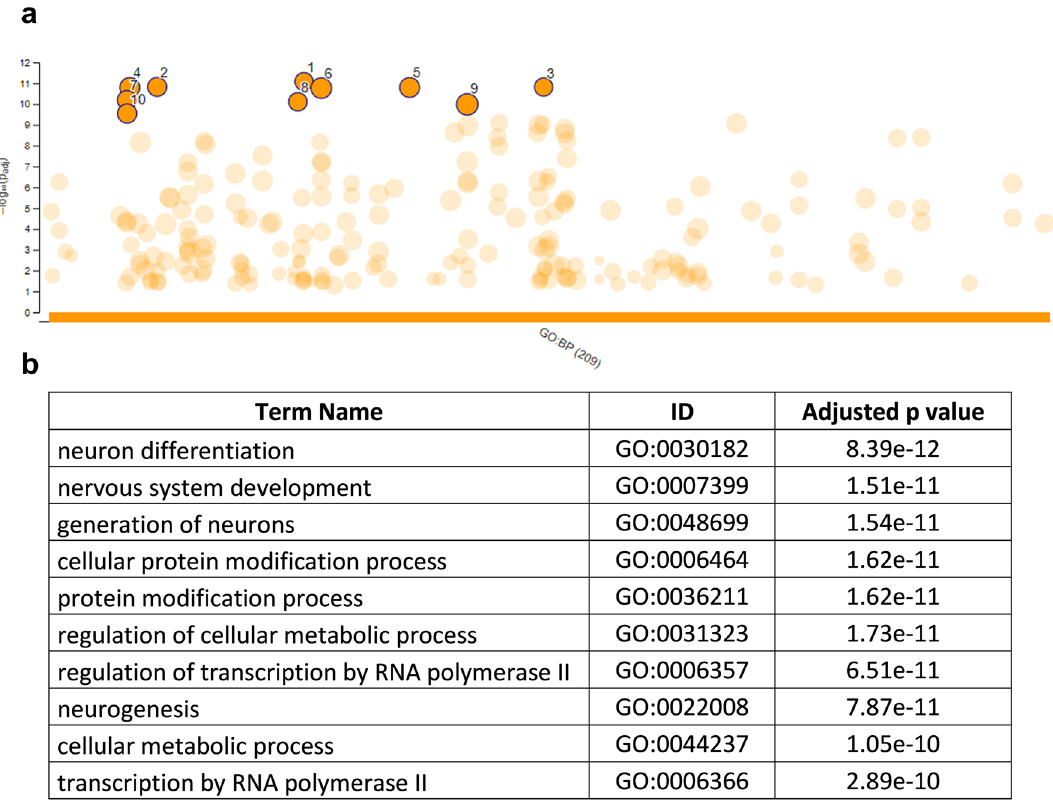
Figure 4. The 209 enriched biological processes controlled by miR-548l from at least 2 of the database lists. ( a ) the enriched biological processes of genes under the control of miR-548l ( b ) tabular result of the adjusted p values of 10 selected enriched terms. The data is presented as a Manhattan plot with the y axis representing the -log10 adjusted p value and GO ID number along the x axis, so that similar terms cluster on this plane. The functional enrichment analysis was performed using g:Profiler with g:SCS multiple testing correction method applying significance threshold of